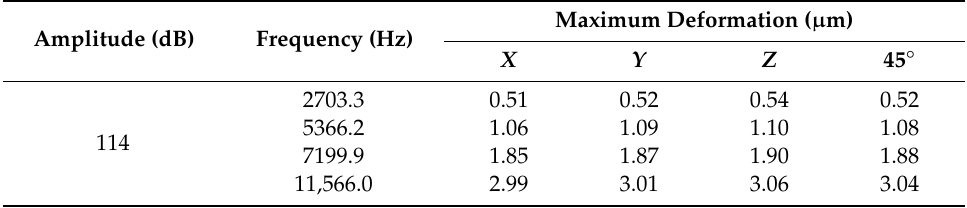
Table 4. Maximum deformations of MPU6050-Y under acoustic injection in di ff erent sound